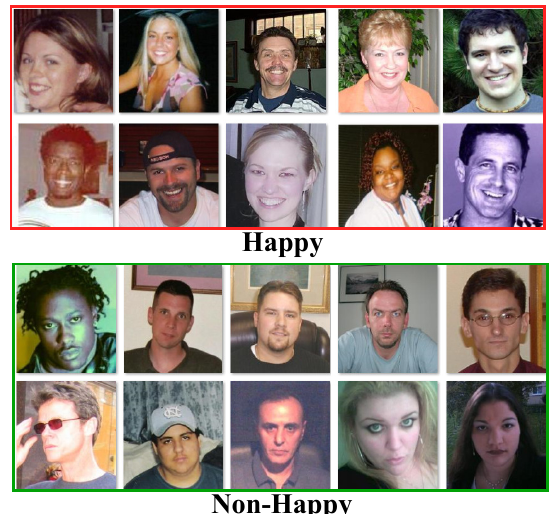
Figure 8. Some image samples from the GENKI database.